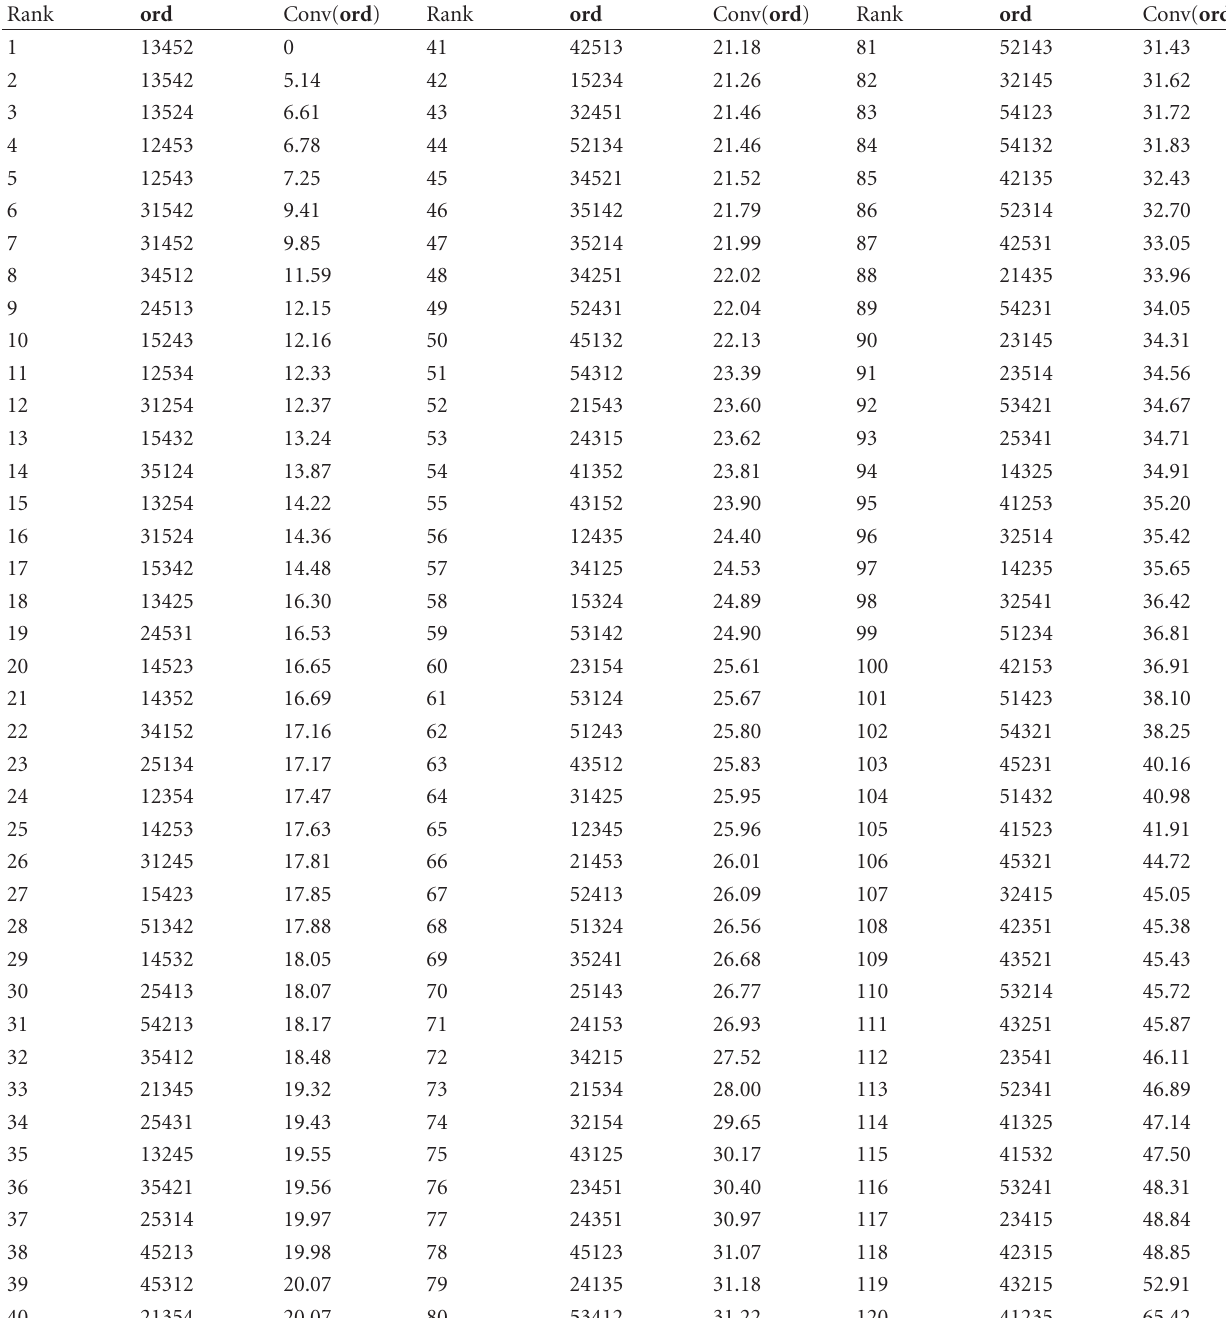
Table 6: Ranking of the de-orbit